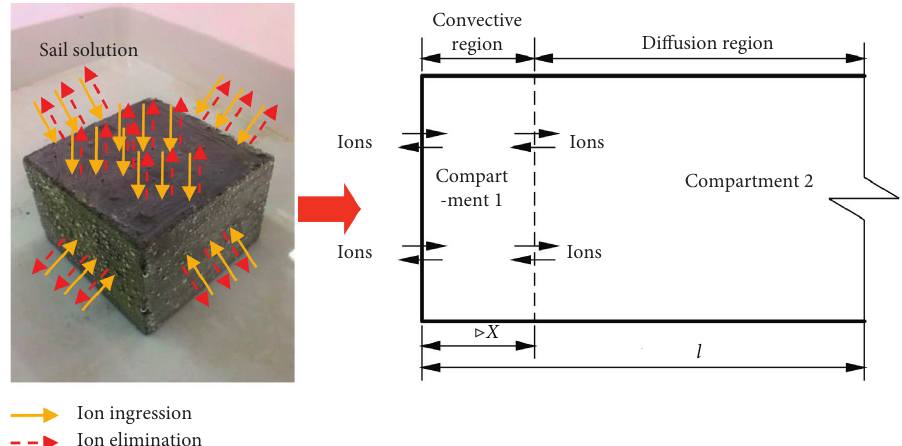
Figure 2: Ion transportation under the drying-wetting cycle (entity figure and simplified model